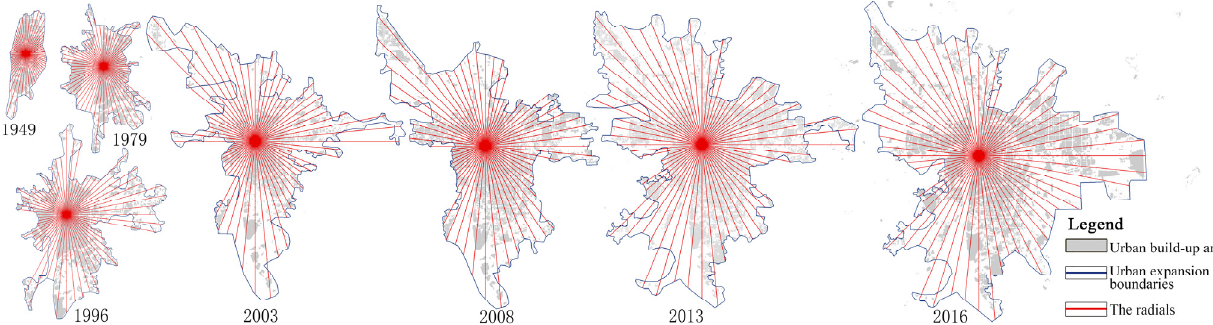
Figure 1. Urban space shape index. Table 2. Results of urban land expansion intensity.